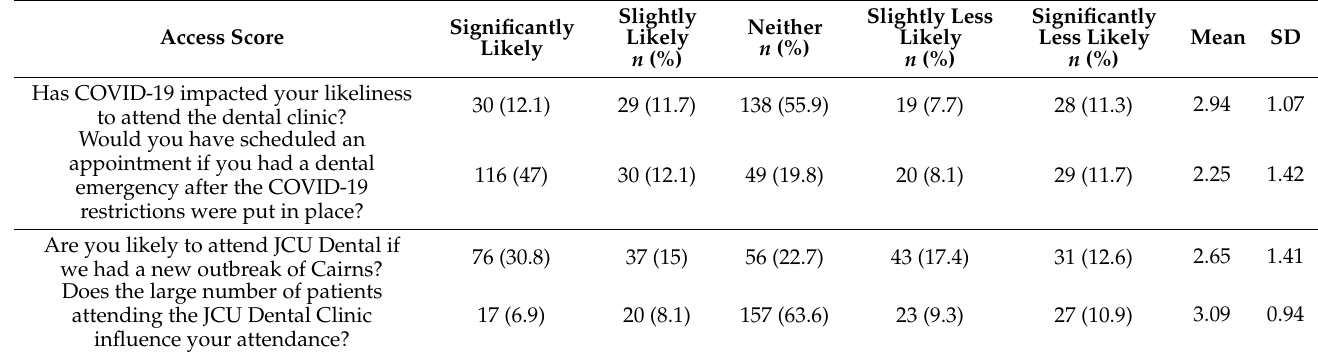
Table 4. Responses to questionnaire items on attitudes regarding dental visits during the COVID-19 pandemic (responses are based on a 5-point Likert scale).